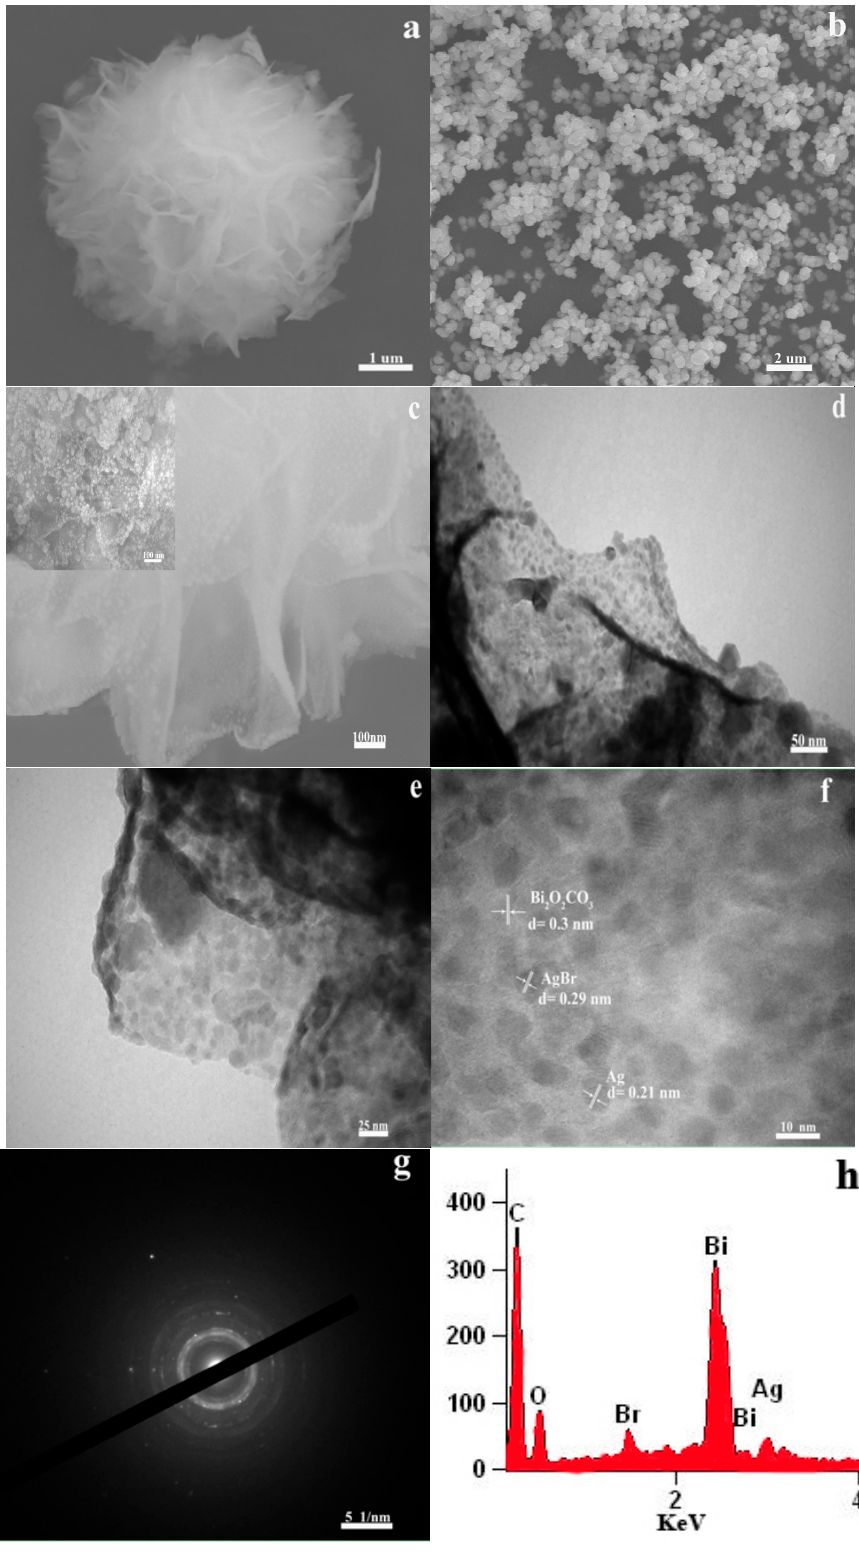
Figure 2. SEM images of: ( a ) Bi 2 O 2 CO 3 ; ( b ) Ag@AgBr; and ( c ) Ag@AgBr(7 wt %)/Bi 2 O 2 CO 3 . The inset of ( c ): Ag@AgBr(11 wt %)/Bi 2 O 2 CO 3 . TEM image of: ( d , e ) Ag@AgBr(7 wt %)/Bi 2 O 2 CO 3 . HRTEM image of ( f ) Ag@AgBr(7 wt %)/Bi 2 O 2 CO 3 . SAED image of the ( g ) Ag@AgBr(7 wt %)/Bi 2 O 2 CO 3 . EDX image of ( h ) Ag@AgBr(7 wt %)/Bi 2 O 2 CO 3 .